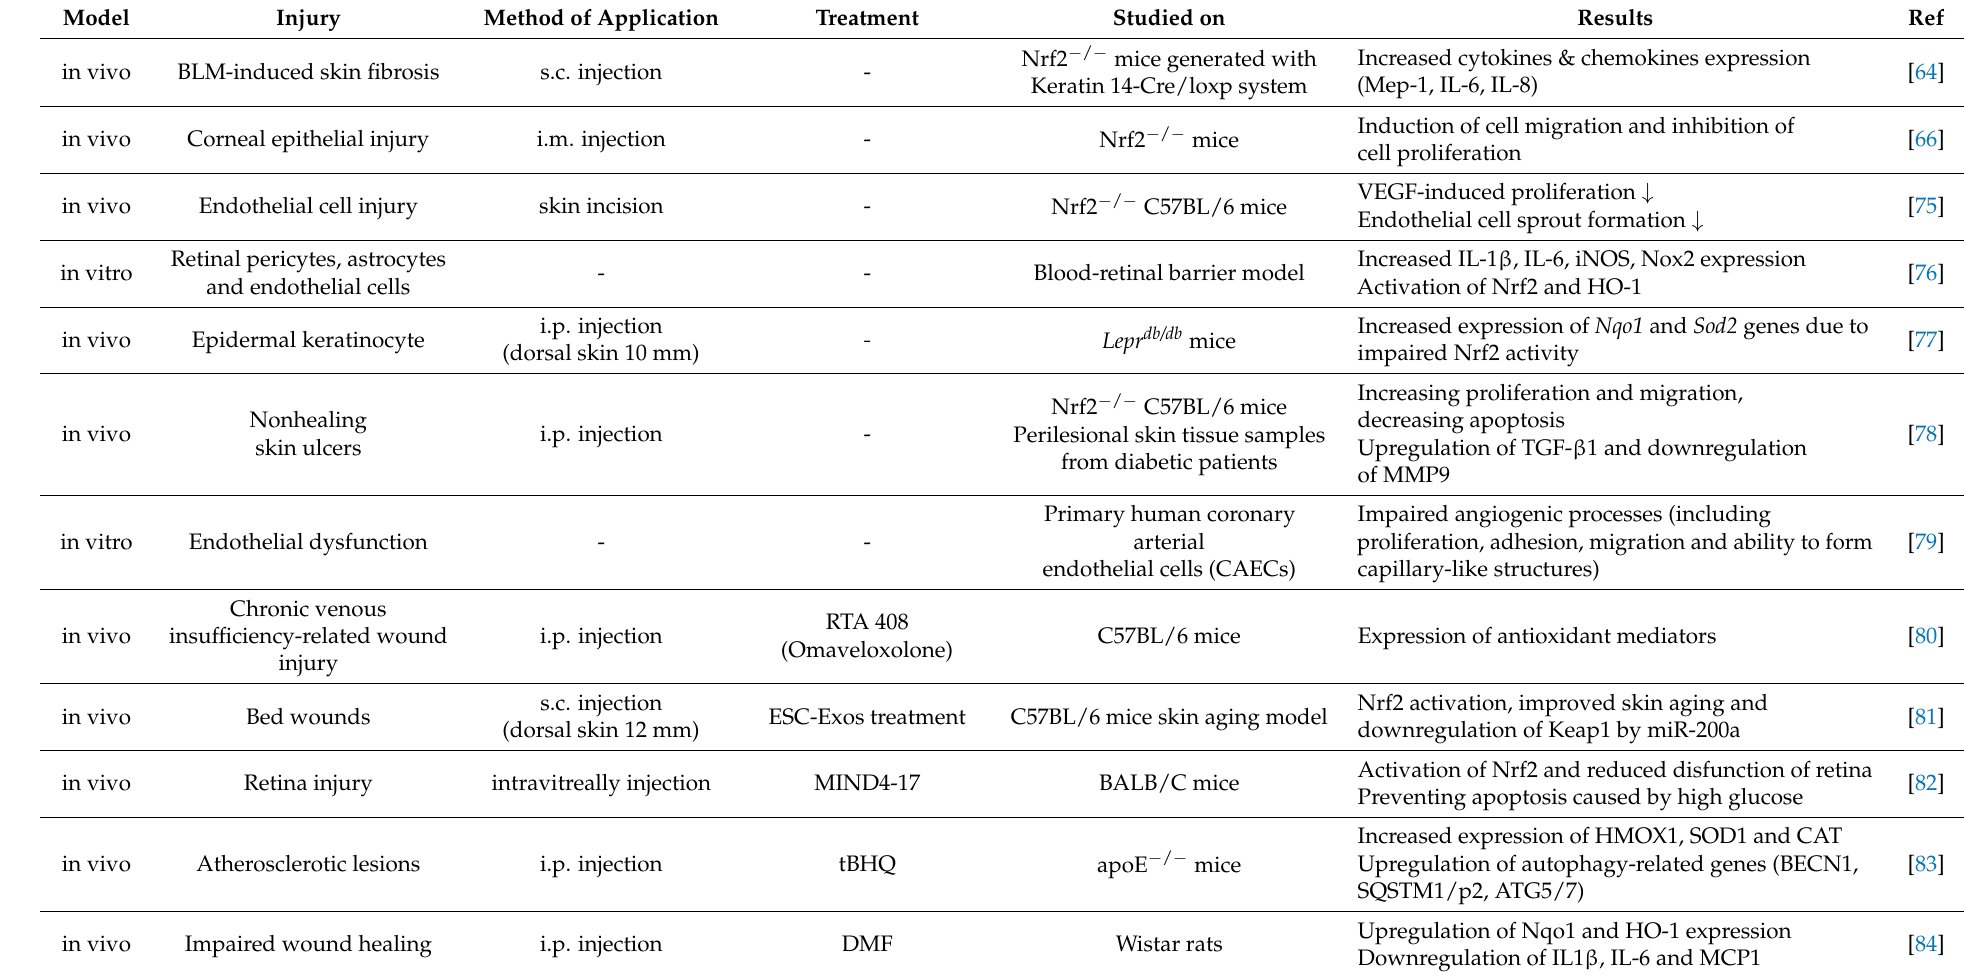
Table 1. Studies targeting Nrf2 activation against tissue